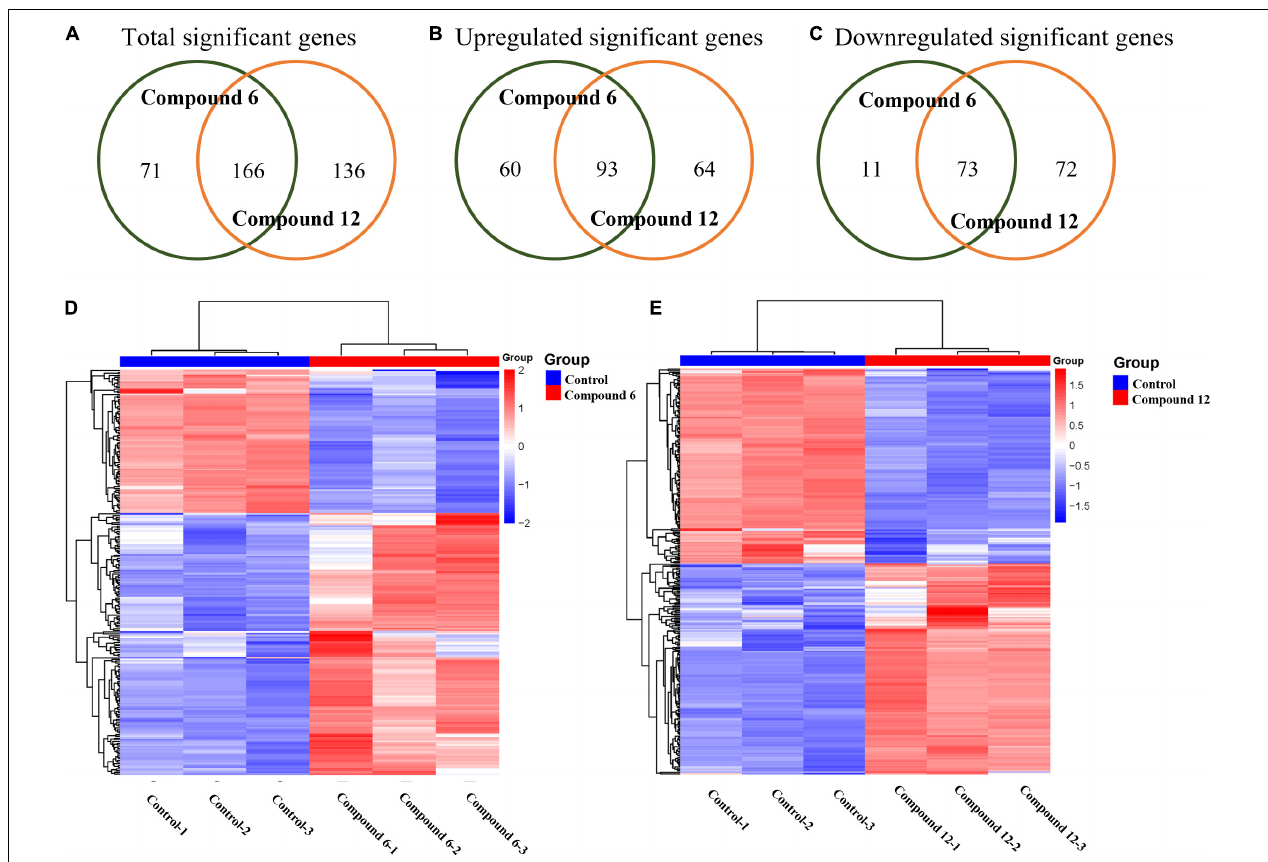
FIGURE 8 | Gene expression analysis of MRSA biofilm cells treated with compounds 6 and 12 at concentration of 100 µ g/ml. (A–C) Venn diagrams of total significant, upregulated, and downregulated significant genes in MRSA biofilm cells due to compounds 6 and 12 treatments. Heatmaps of the cluster analysis of differentially expressed genes between control group compared with compounds 6 (D) and 12 treatment group (E) . Numbers 1–3 represent the three replicates. The normalized log-transformed counts are indicated by the color key. Red indicates upregulations, white represents intermediate expression, and blue indicates downregulations in the